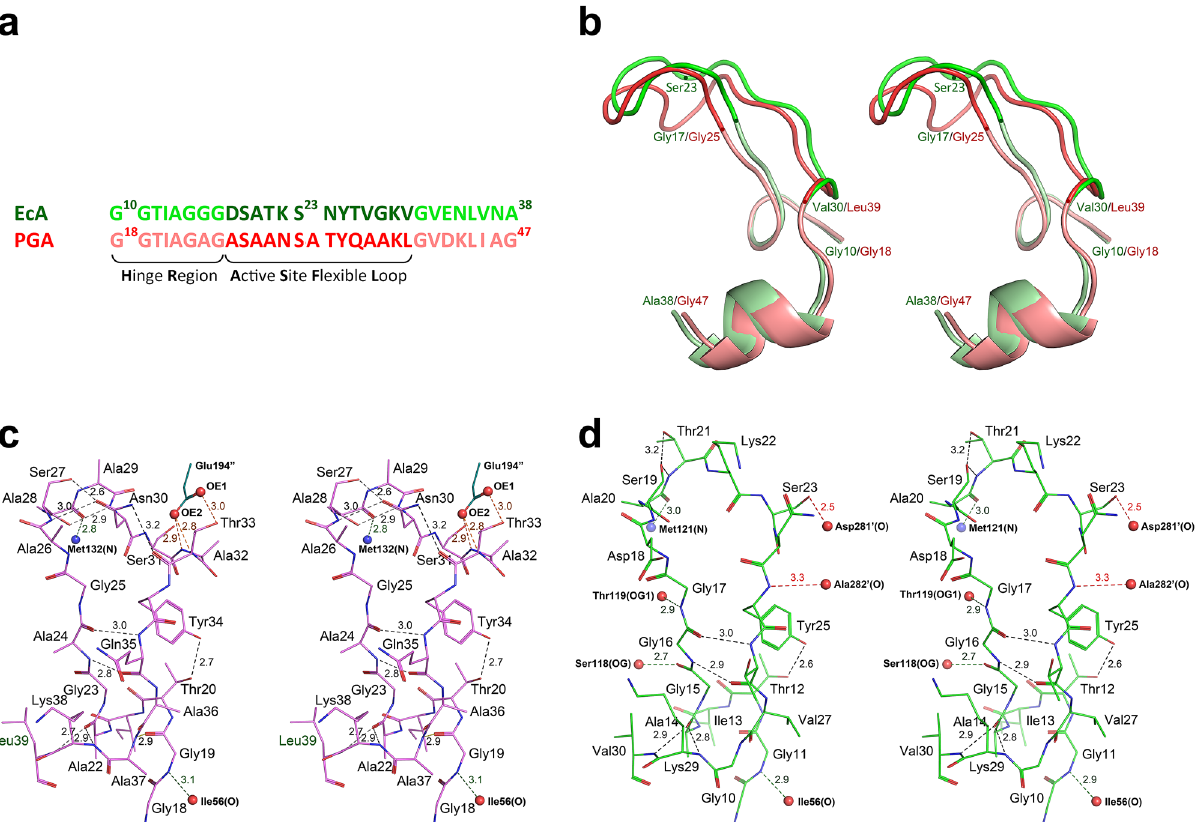
Figure 3. Catalytic ( cat +) conformations of the HR and ASFL regions in PGA and EcAII. ( a ) Structure-based amino acid sequence alignment for the extended sections containing HR and ASFL motifs of both enzymes. ( b ) Ribbon representation of the aligned sections of PGA (protomer C in structure 3, complex with L-Glu, shades of red) and EcAII (protomer A in 6pac, complex with L-Asp, shades of green), corresponding to sequences shown in panel a . Differences in conformations of two ASFLs, resulting from one residue insertion in PGA, are clearly visible. (c) Structural details of HR and ASFL in the complex of PGA with L-Glu (monomer C in structure 3). A majority of H-bonds (colored black) are between atoms within flexible fragment shown in this panel, stabilizing its conformation. Two H-bonds, marked in green, are formed with atoms from other fragments of the same protomer (labeled with smaller bold font) and additional two H-bonds, shown in orange, with Glu194", contributed by a protomer from another dimer. ( d ) An equivalent fragment of the complex of EcAII with L-Asp (protomer A in 6pac). In panels c and d, all H-bonds are marked with dashed lines, assisted by corresponding distances. Figure was prepared with the licensed programs PyMol ver. 2.3.2, (Schrodinger LLC) and Adobe Photoshop CC